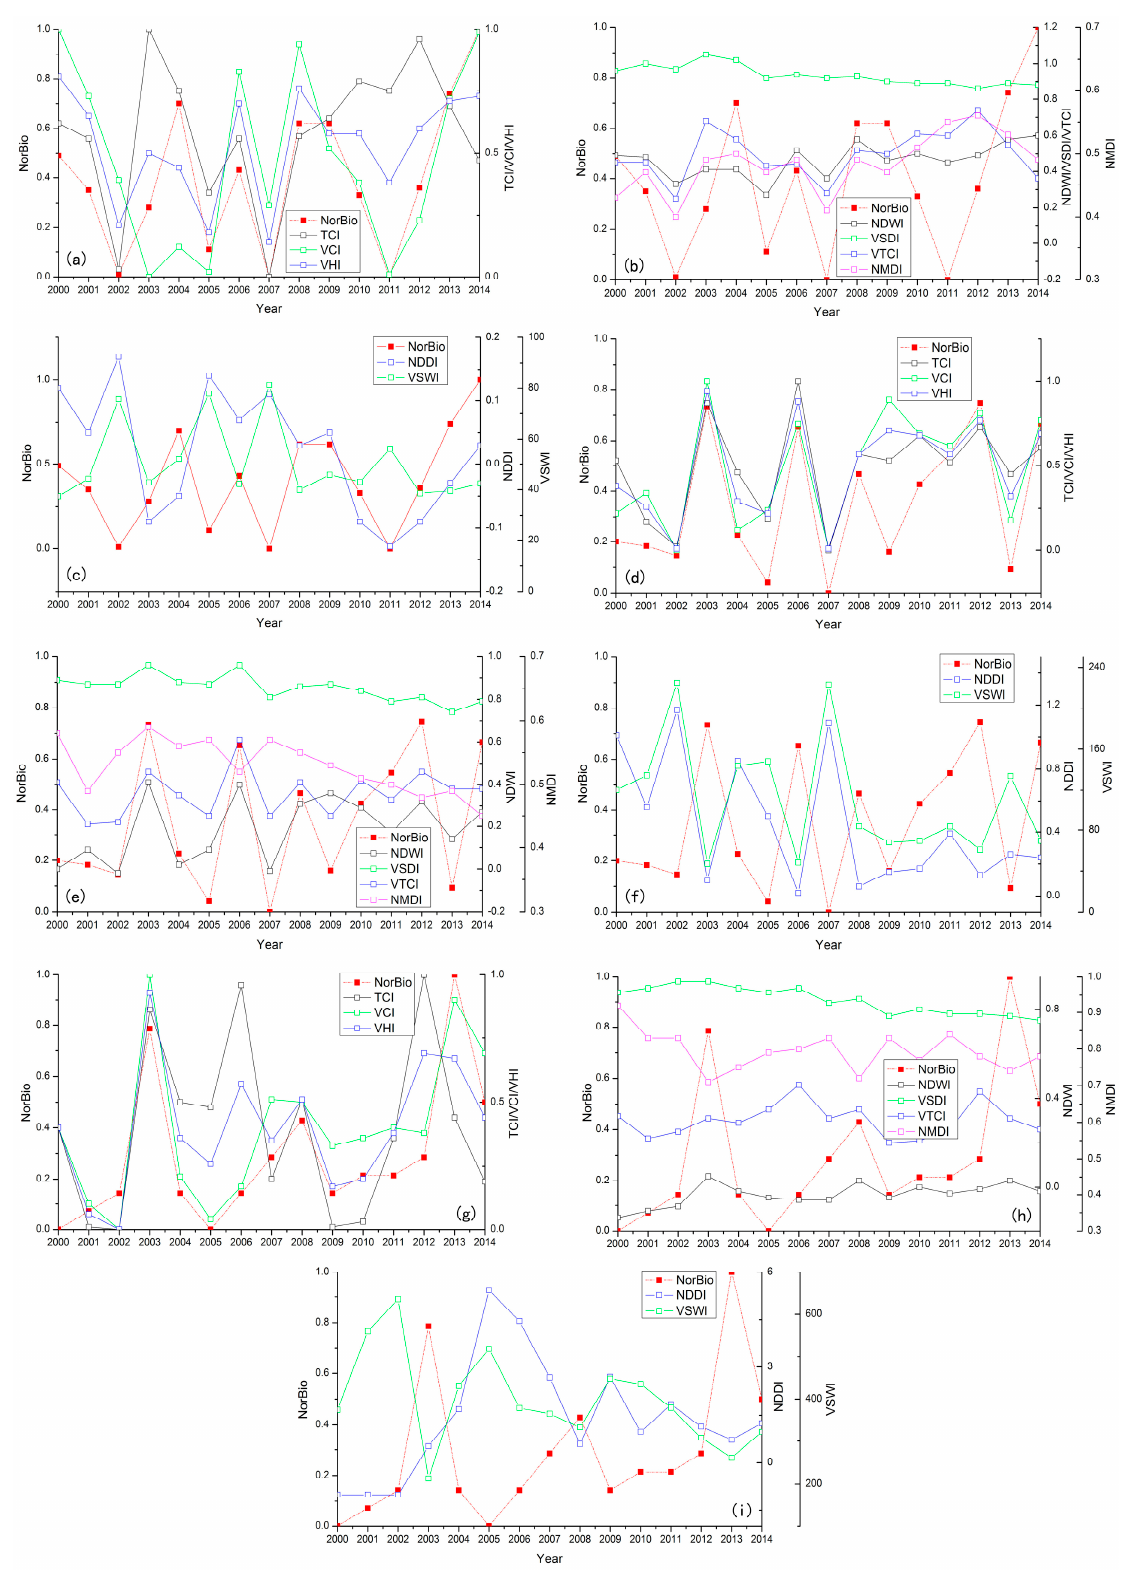
Figure 4. Time series plots of nine RS-derived drought indices relative to the NorBio for the last 10 days of July 2000–2014 for the three land-cover classes: ( a – c ) forest steppe; ( d – f ) steppe; ( g – i ) desert steppe.